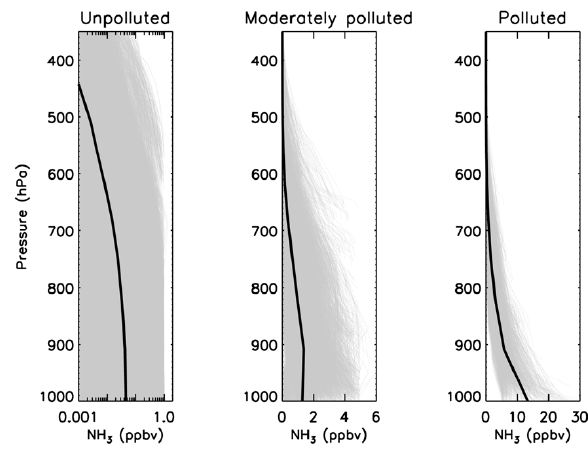
Fig. 3. Three sets of atmospheric NH 3 monthly mean profiles (gray) Figure 2: Three sets of atmospheric NH 3 monthly mean profiles (gray) from GEOS-Chem 2005 global model simulations. The mean profile for each set is shown in black. These from GEOS-Chem 2005 global model simulations. The mean pro- three mean NH 3 profiles constitute the TES NH 3 retrieval a priori profiles. file for each set is shown in black. These three mean NH 3 profiles constitute the TES NH 3 retrieval a priori profiles.